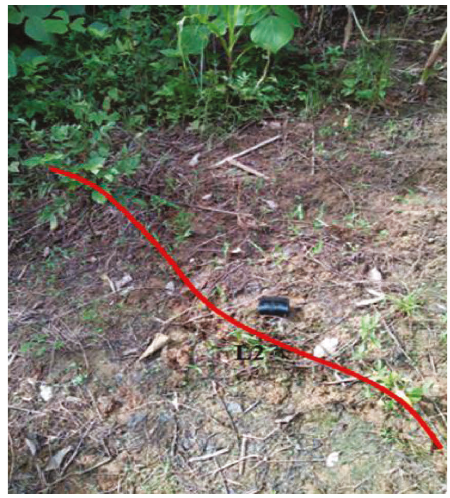
Figure 17: Leading edge bulging of the landslide.